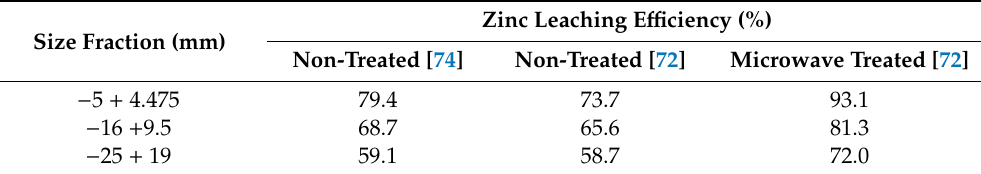
Table 4. Zinc leaching e ffi ciency for non-treated and microwave-treated samples [70].